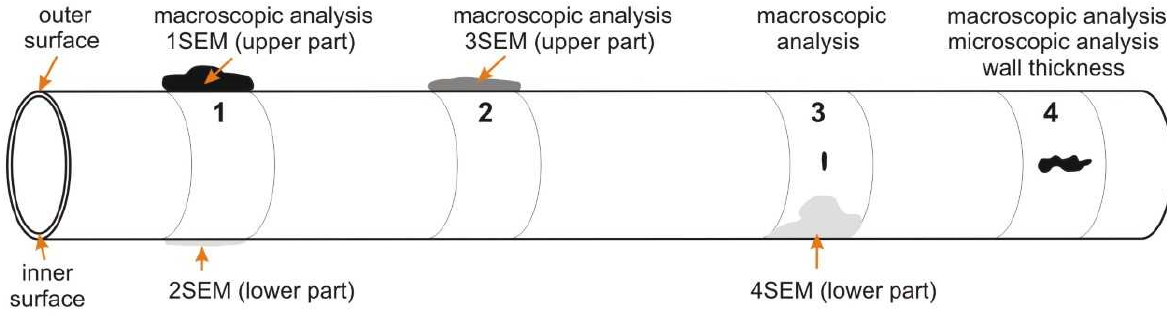
Figure 2. Schema of evaporator tube with the location of cutouts assigned for analyses according to Table 3. Table 3. Marking of evaporator tube cutouts for analysis and corrosion test.